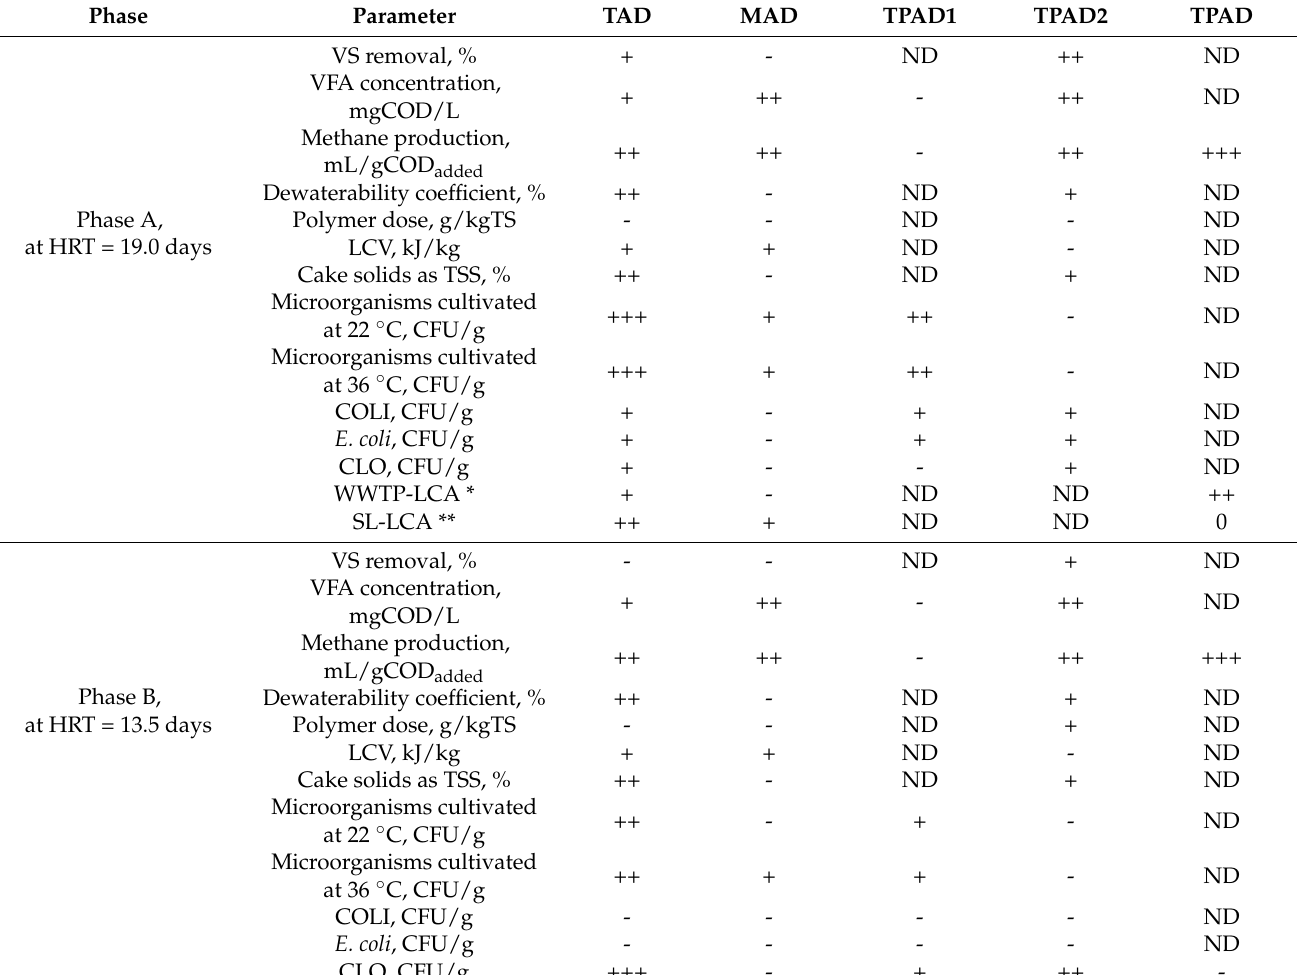
Table 12. Comparison of the obtained data concerning TAD, MAD and TPAD. Phase Parameter TAD VS removal, %